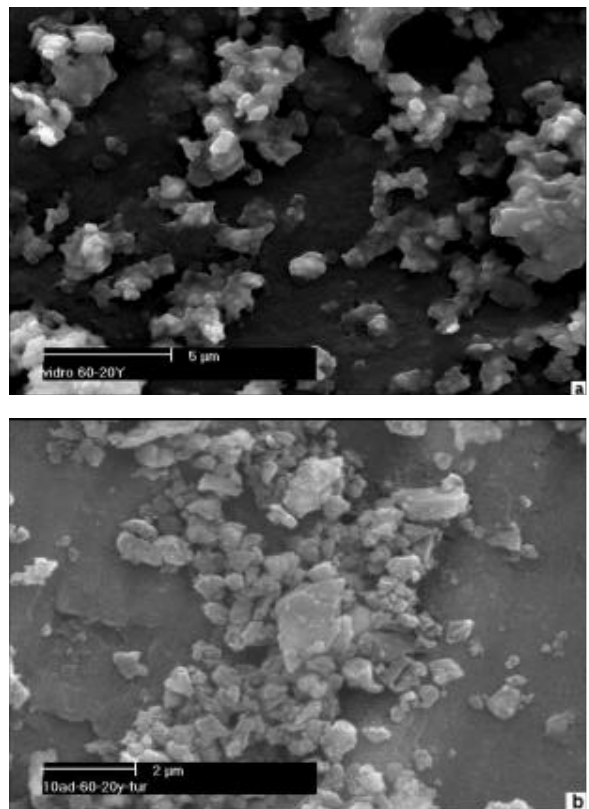
Fi gu re 3. Pow der scan ning elec tron mi cro graphs. a) typi cal ad di ti